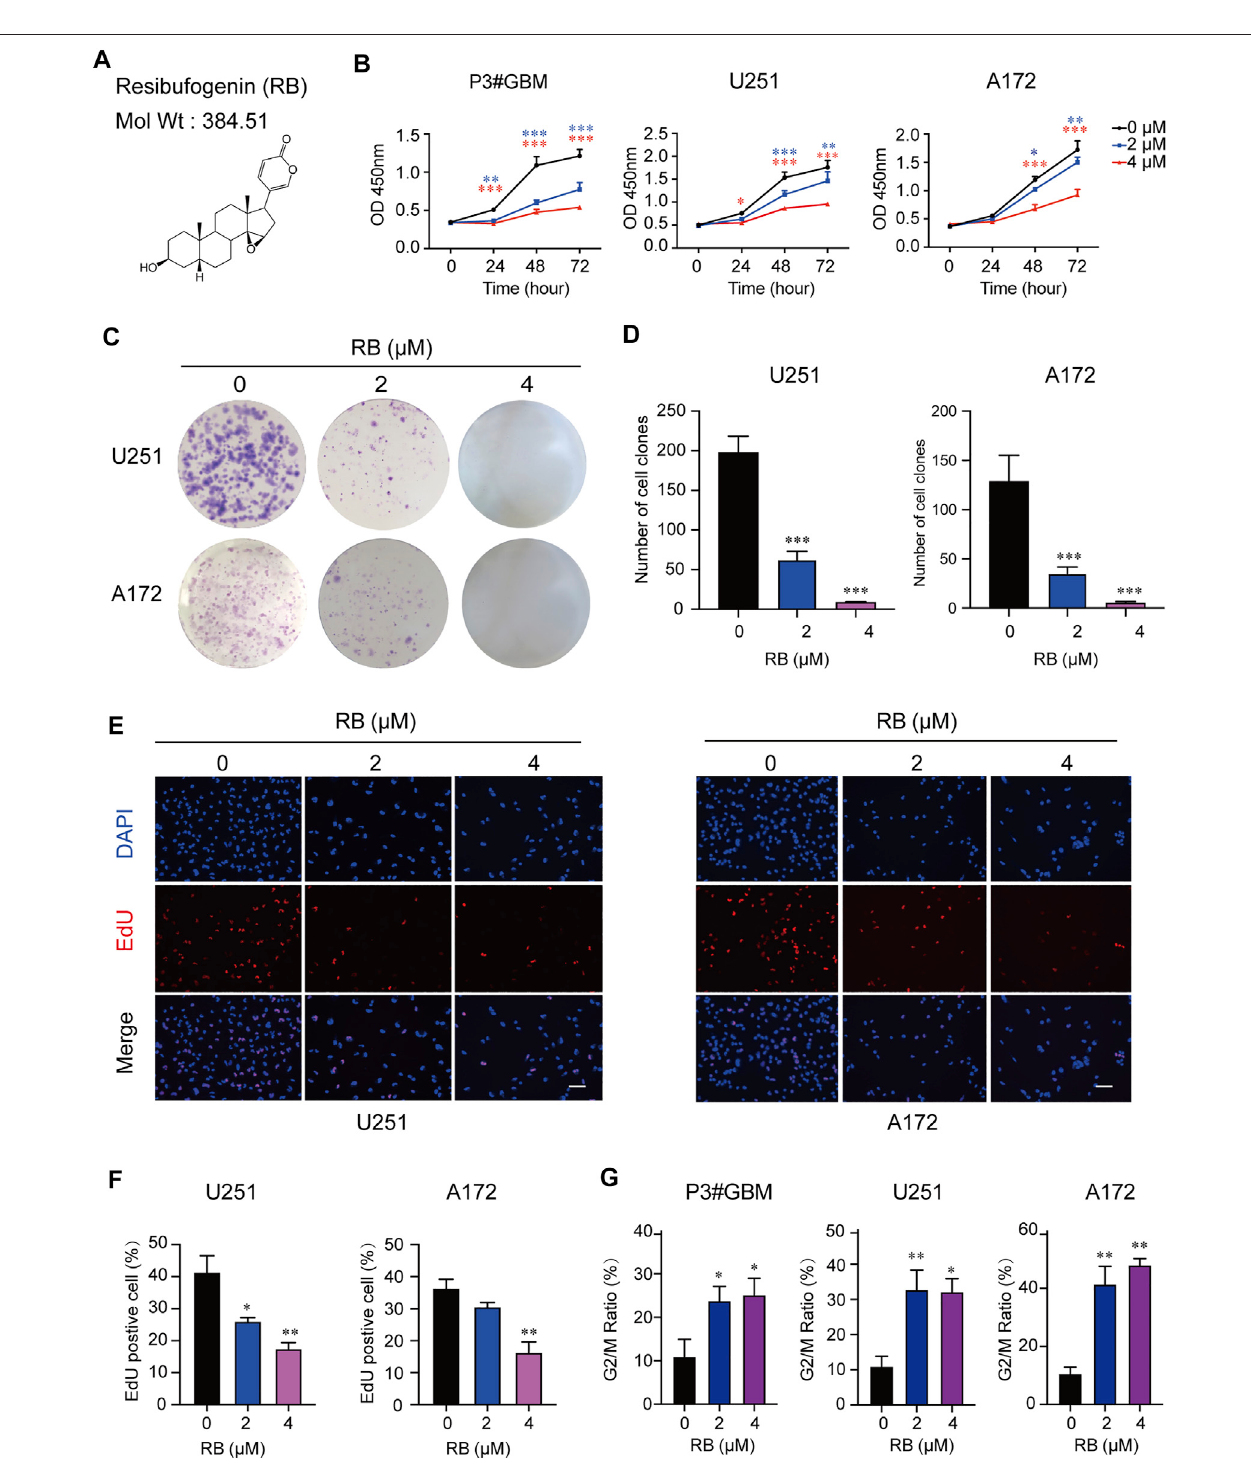
FIGURE 1 | RB inhibits GBM cell proliferation and induces GBM cell cycle arrest in the G2/M phase. (A) Chemical structure of RB drawn through ChemDraw 20.0. The molecularweightofRBis384.51 g/mol.ThetopologicalpolarsurfaceareaofRBis59.06.P3#GBM,U251andA172GBMcellsweretreatedwith2 μ Mor4 μ MRBundernormal cultureconditions. (B) UsingtheCCK-8assay,proliferationcurvesofP3#GBM,U251andA172GBMcellstreatedwithvehicle,DMSO(0),2 μ Mor4 μ MRBfor0,24,48or72 h. (C) RepresentativeimagesofthecellcloneformationassayforU251andA172cellsgivenDMSO(0),2 μ Mor4 μ MRB. (D) Graphicrepresentationofthenumberofcolonies shownin (C) . (E) EdUassaysconductedonU251andA172cellstreatedwithvehicle,DMSO(0)and2or4 μ MRBfor48 h.EdUwasdetectedbyApollo567staining(red),nuclei werehighlightedbyDAPIstaining(blue),andimagesweremerged.Scalebar,50 μ m. (F) GraphicrepresentationofthepercentagesofEdU-positiveU251andA172cellsshownin (E) . (G) Graphic representation of the percentages of G2/M phase cells calculated from each group ( Supplementary Figure S1B ). Three independent experiments were performed with data shown as the mean ± SEM by two-way ANOVA (B) or one-way ANOVA (D,F,G) . * p < 0.05; ** p < 0.01 and *** p < 0.001.